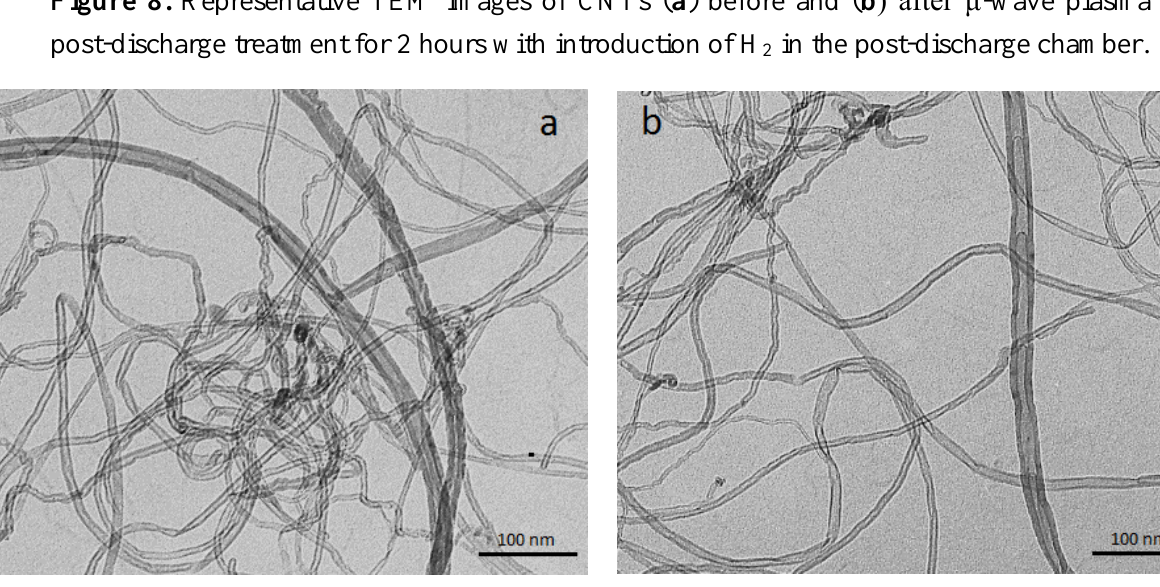
Figure 8. Representative TEM images of CNTs ( a ) before and ( b ) after μ-wave plasma post-discharge treatment for 2 hours with introduction of H